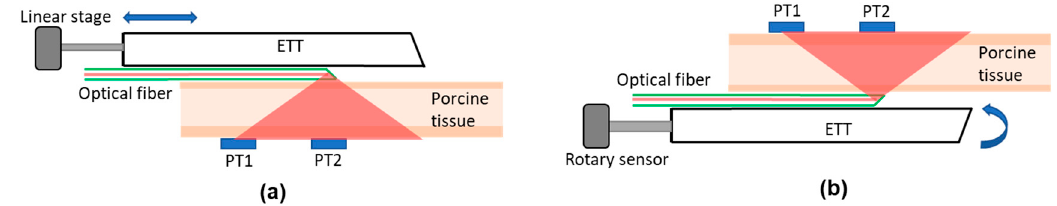
Figure 2. Experimental setups for the ex vivo studies with porcine tissue: ( a ) longitudinal tube displacement and ( b ) tube rotation.